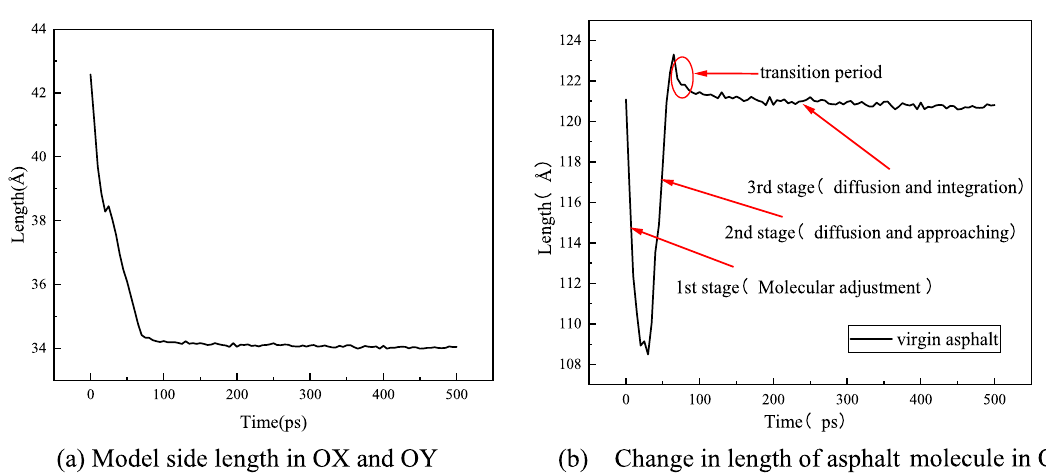
Figure 7. Variation in model side length and asphalt molecular length during self-healing process of virgin